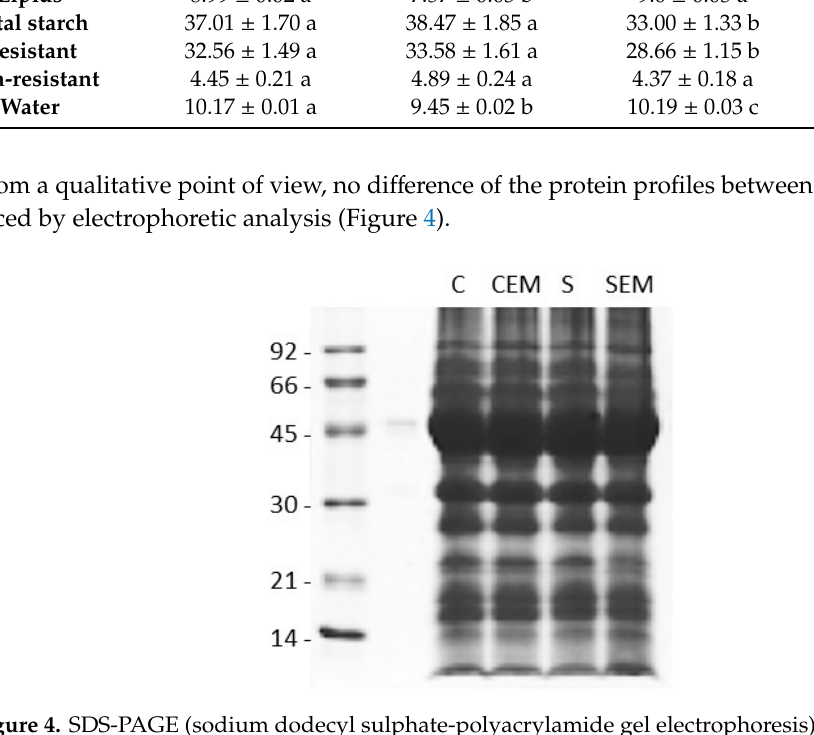
Figure 4. SDS-PAGE (sodium dodecyl sulphate-polyacrylamide gel electrophoresis) of total protein extracts of seeds from bean plants grown on standard or sandy soils, as such or following EM treatment. See the text for experimental details. C: greenhouse substrate; CEM: greenhouse substrate + EMs; S: sandy soil; SEM: sandy soil + EMs.